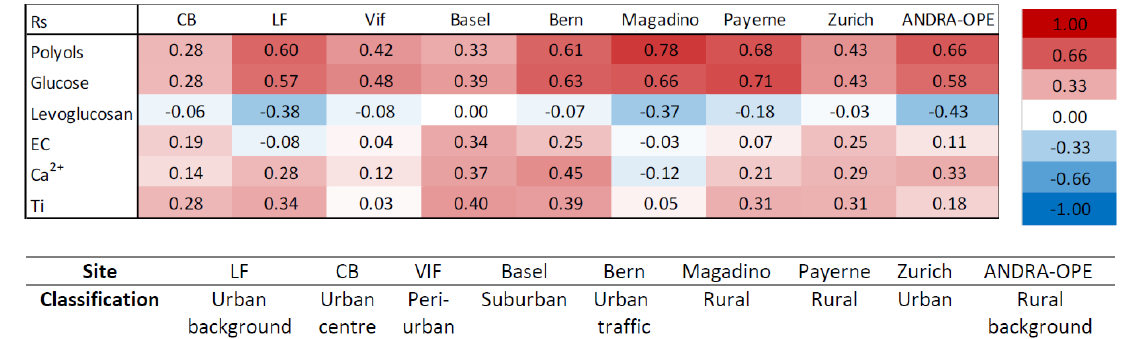
Table 5. Spearman correlations ( R s ) between cellulose and characteristic chemical tracers across the nine sites. A red cell indicates a positive correlation between cellulose and the selected chemical tracer, whilst a blue cell indicates a negative correlation. A colour-coded key of corresponding R s values is to the right of the table. Grenoble-based sites are CB (Caserne de Bonne), LF (Les Frênes), and Vif. Note that polyols row represents the sum of arabitol, mannitol, and